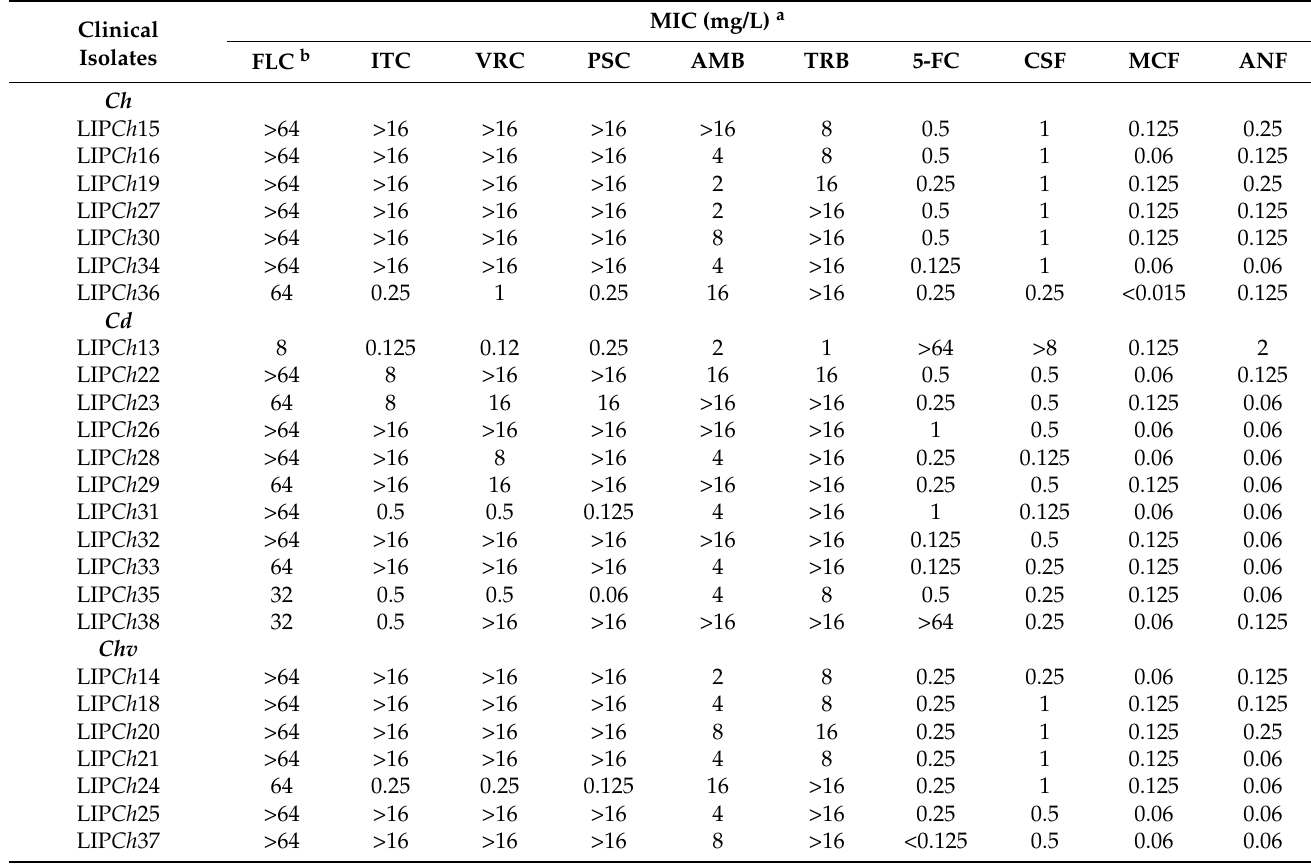
Table 2. MIC values of antifungal agents against each clinical isolate of C. haemulonii species complex studied in the present work.